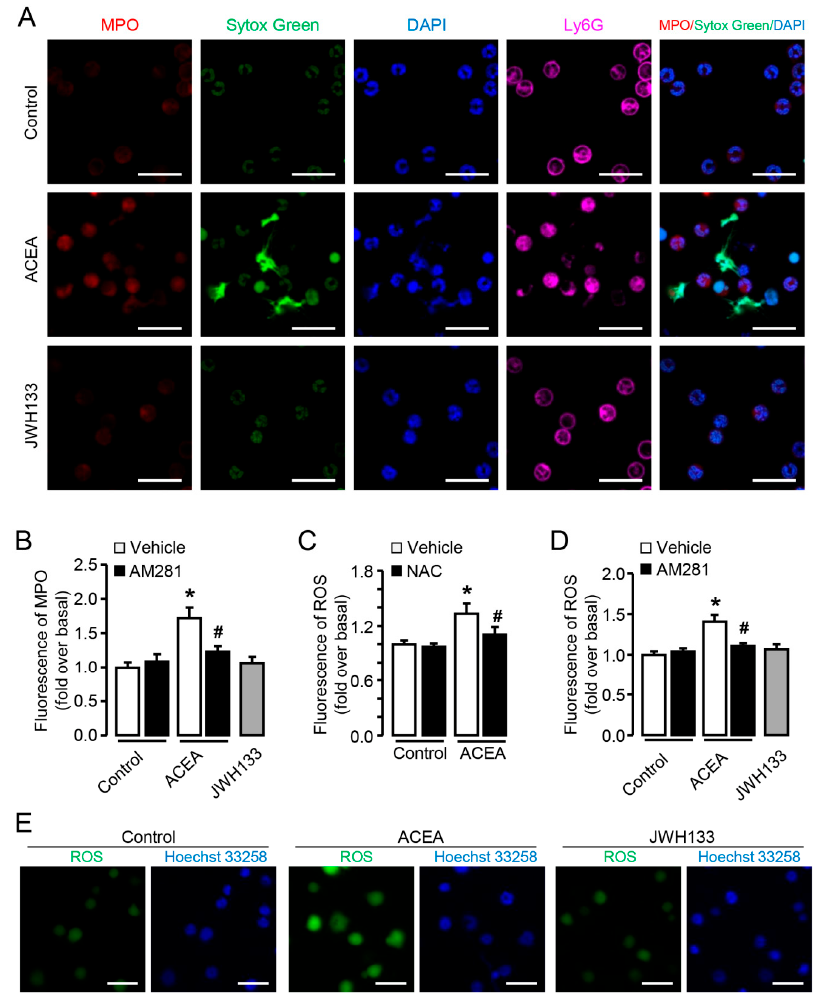
Figure 5. CB1 but not CB2 mediates MPO release and ROS burst in vitro. ( A ) Representative confocal images myeloperoxidase (MPO) (red) and Ly6G (violet) immunofluorescent staining in ACEA or JWH133-stimulated neutrophils. The nuclei were stained with SYTOX ® Green (green) and DAPI (blue). Scale bars, 20 µ m. ( B ) Quantification of MPO in ACEA or JWH133-treated neutrophils. ( C ) ROS burst in ACEA-treated neutrophils with or without NAC. ( D ) ROS burst in ACEA-treated neutrophils with or without AM281. ( E ) ROS immunofluorescence images in ACEA- or JWH-133-treated neutrophils. Data are presented as the mean ± SEM. N = 4 per group. * p < 0.05 vs. control. # p < 0.05 vs. ACEA-treated alone.